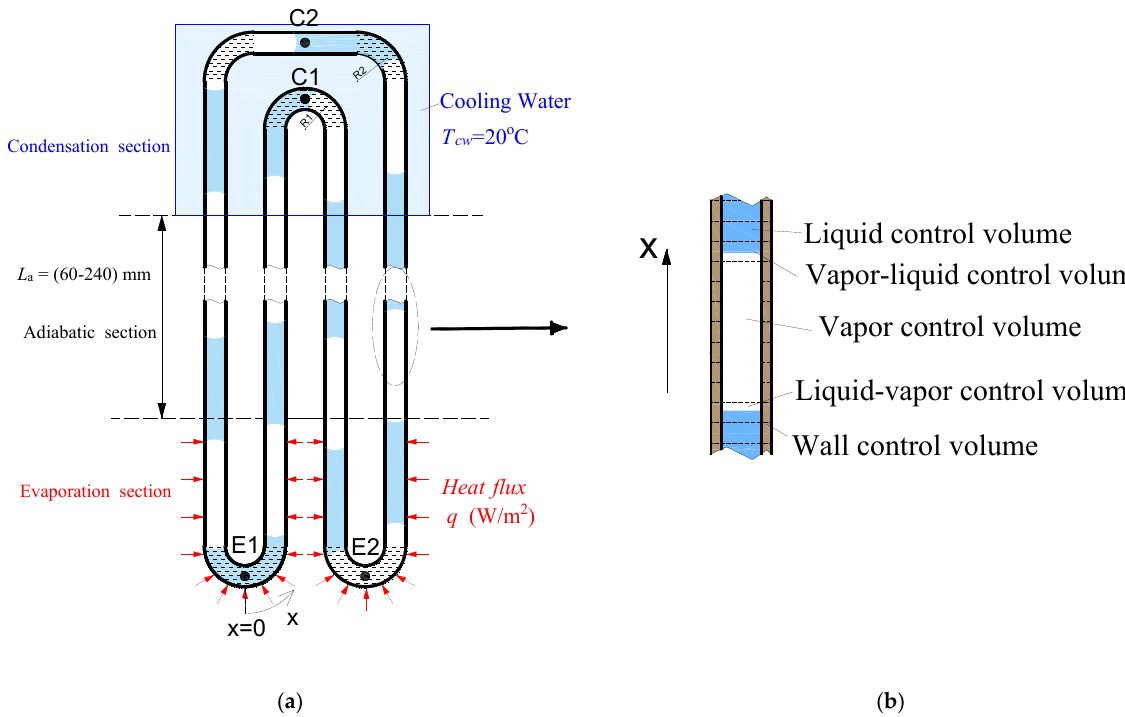
Figure 2. The schematics of ( a ) the physical model and ( b ) the control volumes Table 2. The geometric parameters of the PHP. Parameters Value Number of turns 2 Length of the evaporation section (mm) 60 Length of the adiabatic section (mm) 60, 120, 180, 240 Length of the condensation section (mm)